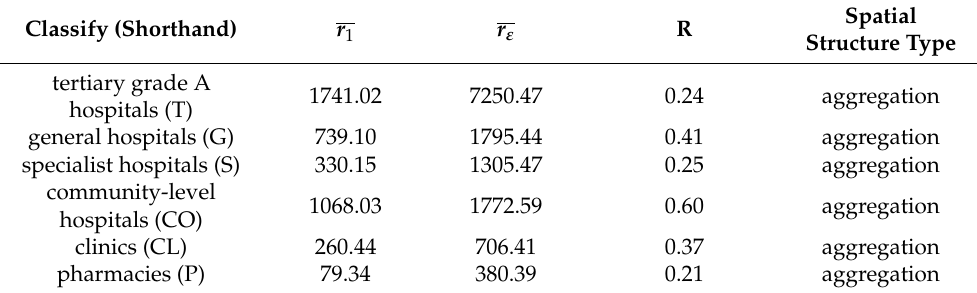
Table 1. Nearest Neighbor Ratio for all types of medical facilities.